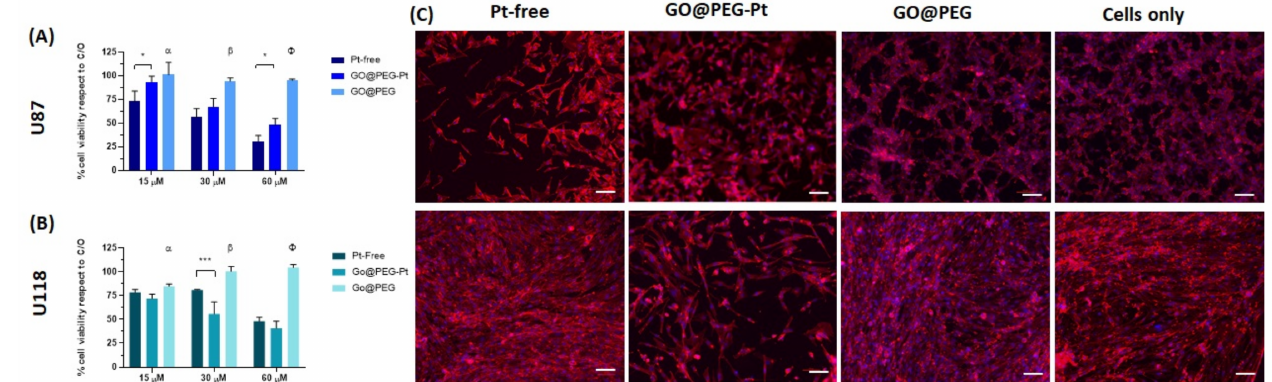
Figure 6. Cell viability and morphological analysis in breast adenocarcinoma cell lines. An MTT assay was performed after 72 h of cell culture. The data show the percentage of viable cells compared to cells alone as the control, and the mean ± standard error of the mean is presented. The graphs show the viability of the MDA-MB-231 cell line ( A ), the MDA-MB 468 cell line ( B ) and the respective morphological images of the cells cultured for 72 h in the presence of the 30 mM concentration. Phalloidin red stains for actin filaments, and DAPI blue stains for cell nuclei ( C ). Scale bars: 100 µ m. (* p -value ≤ 0.05, *** p -value ≤ 0.001). Significant differences between GO@PEG and the other compounds are reported in the graph as follows, a: GO@PEG vs. GO@PEG-Pt p -value ≤ 0.05 in MDA-MB 468. b: GO@PEG vs. Pt-free p -value ≤ 0.01 and GO@PEG vs. GO@PEG-Pt p -value ≤